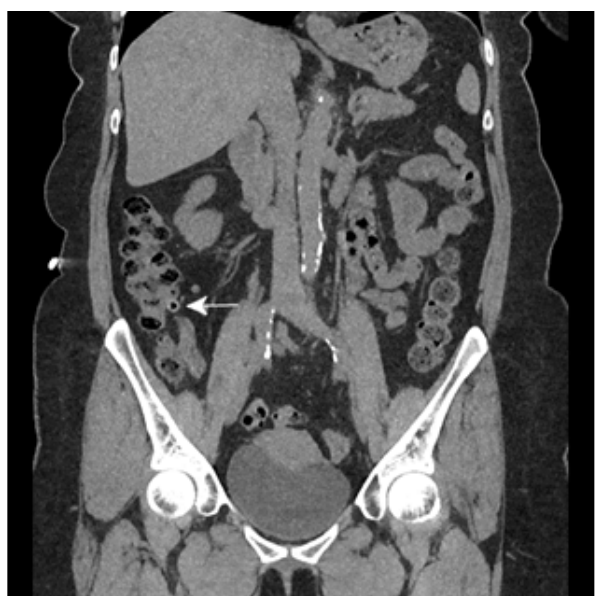
Figure 2. Coronal view of the caecum with multiple diverticulae, one of which has a dense wall (white